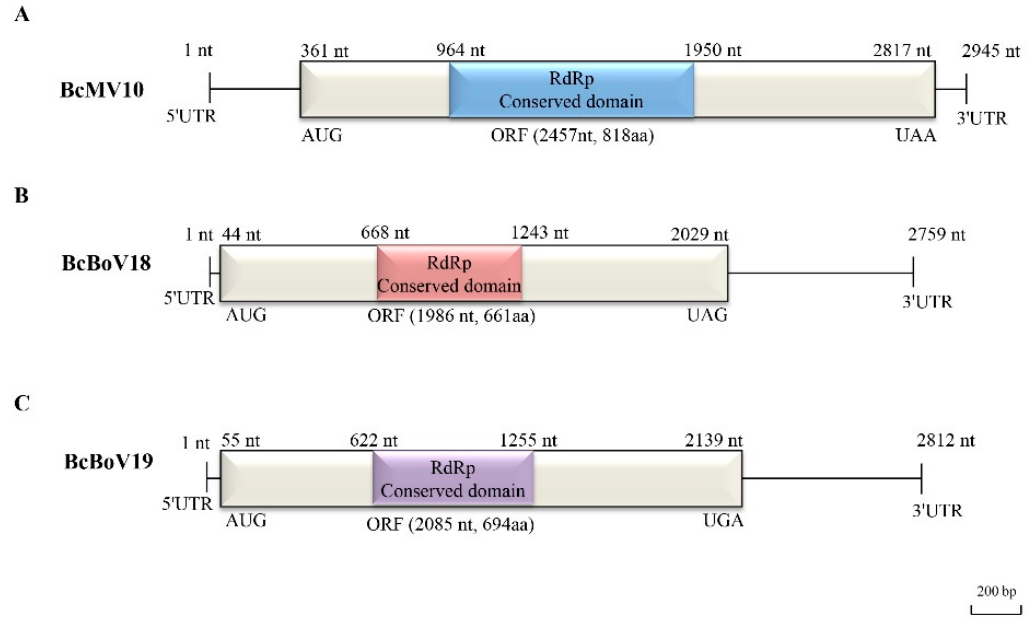
Figure 3. Full-length genome structures of: ( A ) BcMV10; ( B ) BcBoV18; and ( C ) BcBoV19. Each contains one open reading frame (ORF) flanked by two untranslated regions (UTRs) at 3 ′ - and 5 ′ - termini and RdRp conserved domain, which are indicated by an open bar and black lines, and different corresponding colour boxes, respectively.